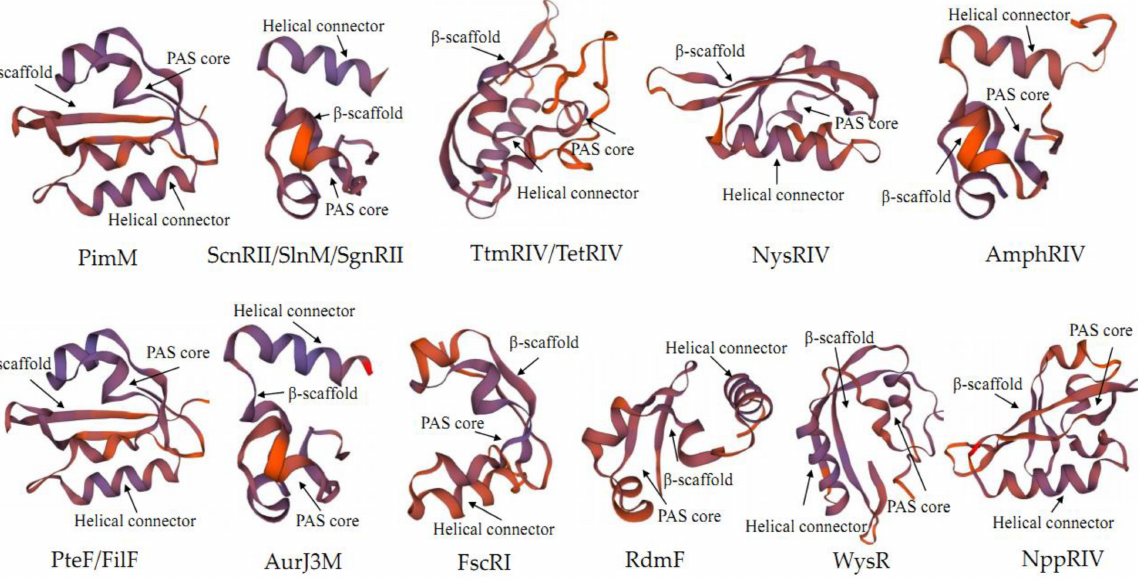
Figure 4. Simulated secondary structures of N-terminal PAS structure of PAS-LuxR family regulators by SWISS-MODEL on https://swissmodel.expasy.org/, accessed on 25 July